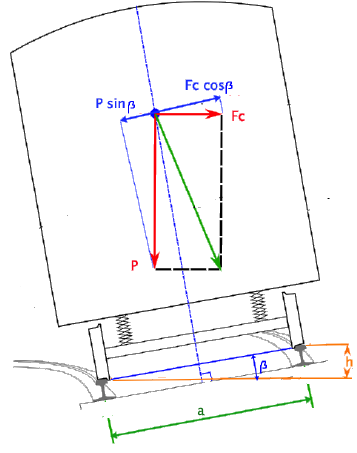
Figure 9. Scheme and calculations.